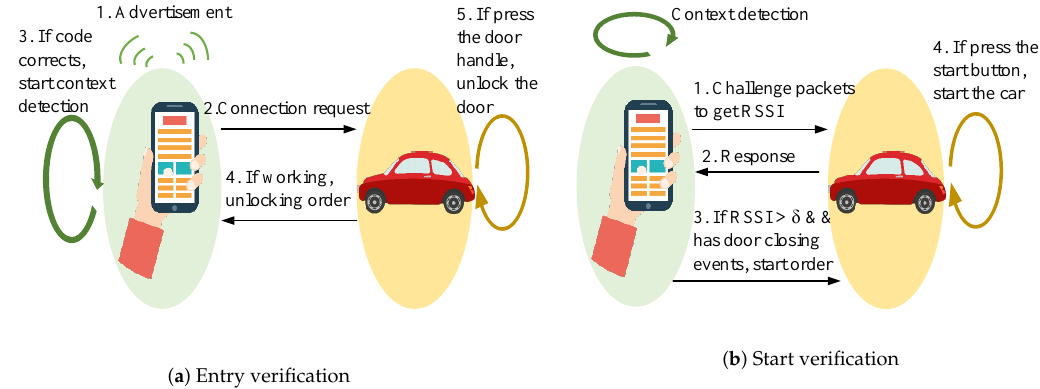
Figure 3. Smartphone-type Passive Keyless Entry and Start system